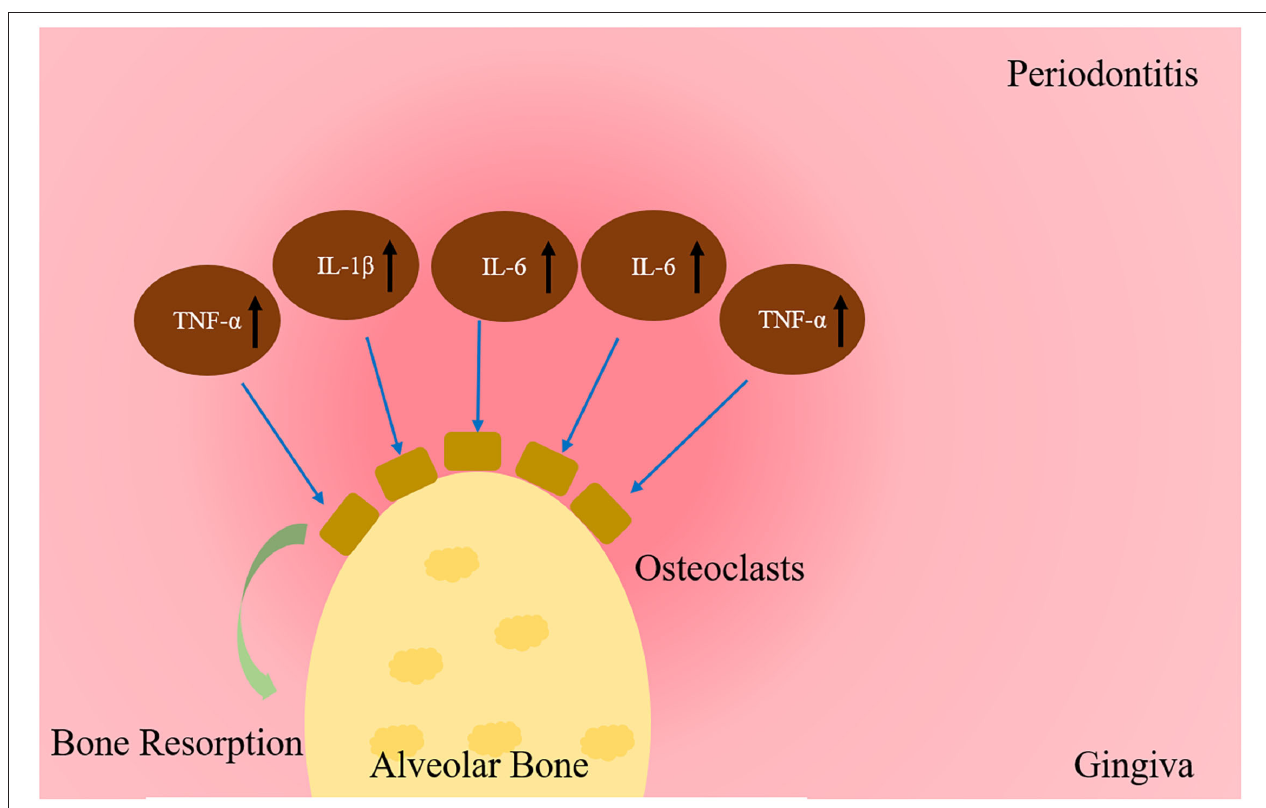
FIGURE 2 | Cytokines regulation of bone resorption in periodontitis. The expression of cytokines in periodontitis increase bone resorption by osteoclasts, such as TNF-a, IL-1 β , IL-6, IL-17 and IFN- γ .